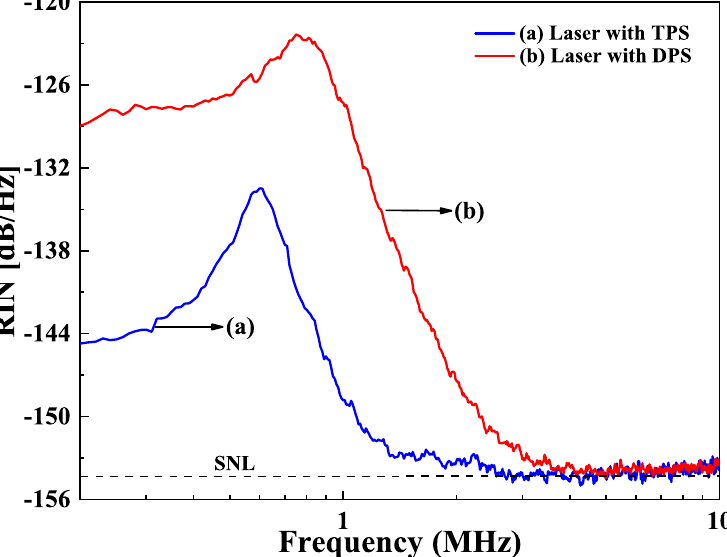
Figure 22. Intensity noise spectra of the single-frequency laser without the nonlinear loss [32]. Reprinted with permission from [32] c (cid:13) The Optical